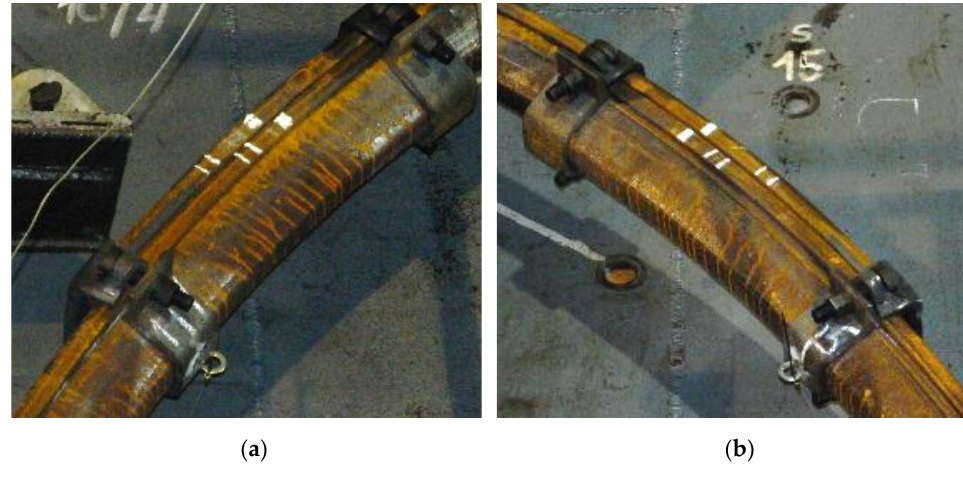
Figure 27. Slide on the support’s frame joints: left side ( a ), right side ( b ).